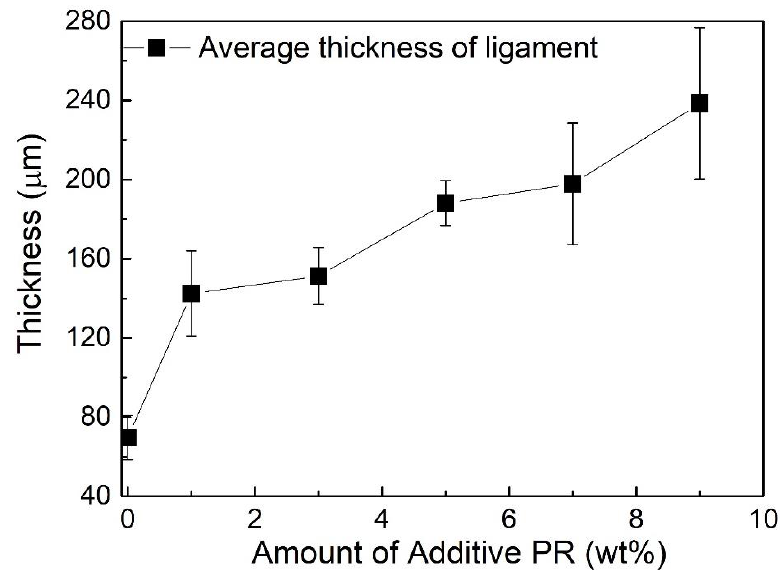
Figure 5. The thickness of as- prepared foams’ ligament varies with increase of amount of additive PR , where the thickness of ligament is 69.6 ± 11.2 μm for 0 wt% PR, 142.4 ± 21.6 μm for 1 wt%, 151.2 ± 14.4 μm for 3 wt% , 188.1 ± 11.3 μm for 5 wt% , 197.8 ± 30.7 μm for 7 wt% and 238.5 ± 38.2 μm for 9 wt%, respectively.